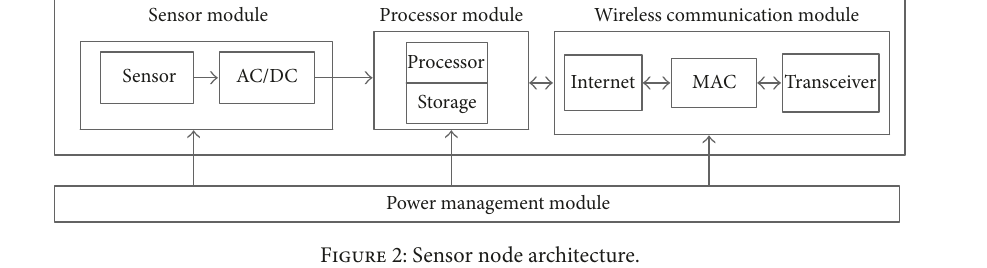
Figure 2: Sensor node architecture.